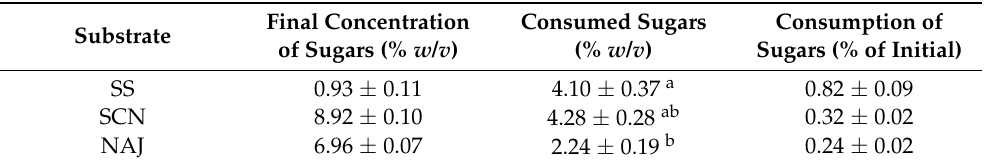
Table 4. Final concentration of sugars and total estimated sugars consumption during the 24 h fermentation of different sugary solutions with acclimated kefir grains. SS, Sucrose solution; SCN, sour cherry nectar, NAJ, natural apple juice. Values in each column that share the same letter do not differ significantly from each other (Mann–Whitney